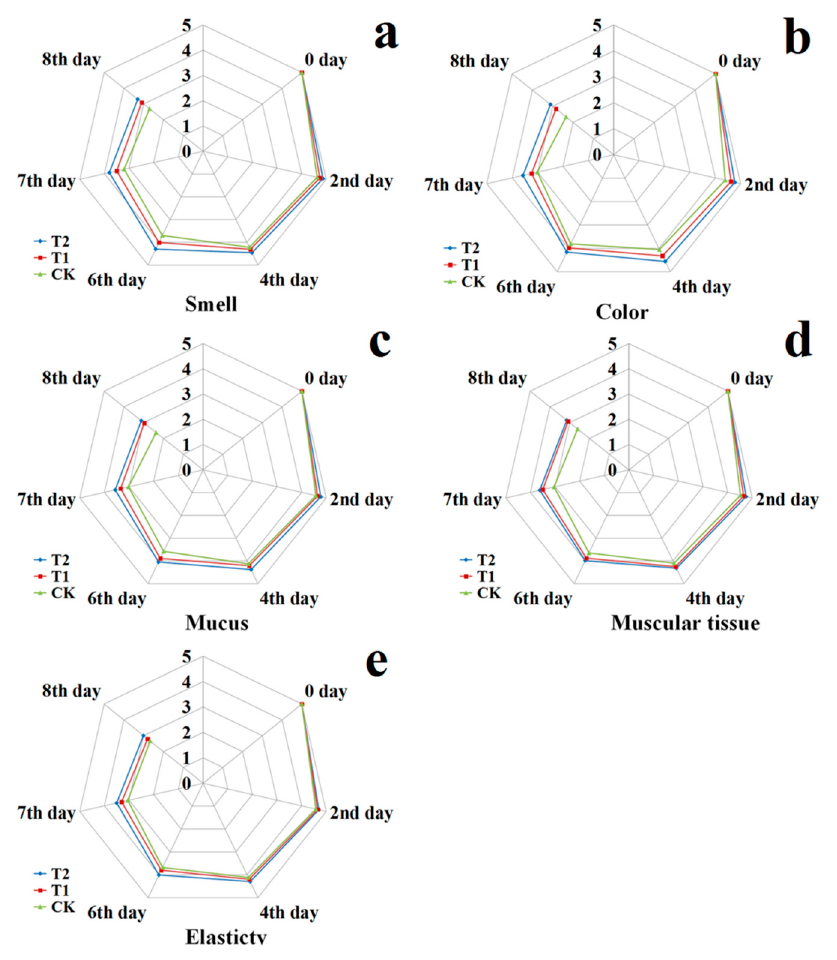
Figure 3. Changes in the organoleptic evaluation results (smell: a ; color: b ; mucus: c ; muscular tissue: d ; elasticity: e ) of salmon fillets treated with bacteriocin EFL4 during cold storage at 4 °C (CK: control; T1: salmon treated with 1MIC bacteriocin EFL4; T2: salmon treated with 2MIC bacteriocin EFL4).